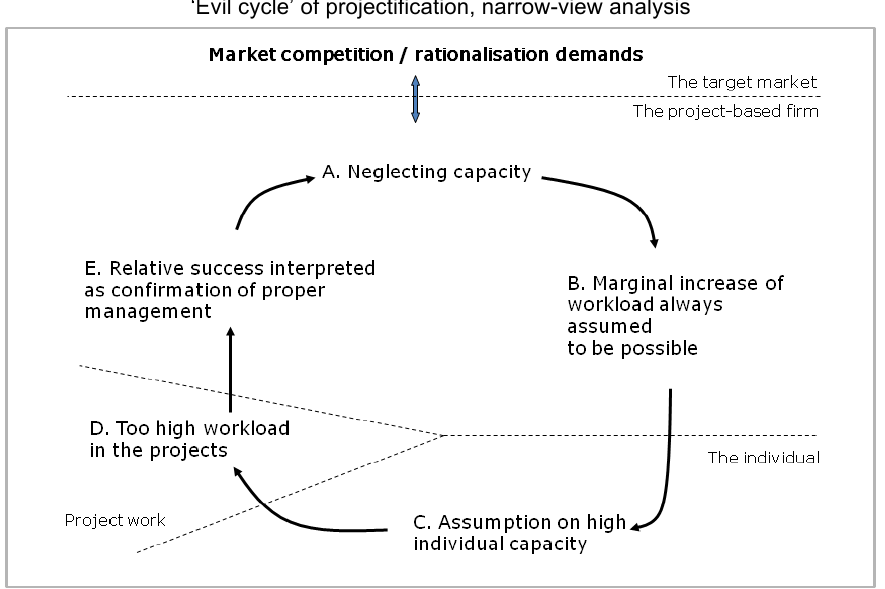
‘Evil cycle’ of projectification, narrow-view